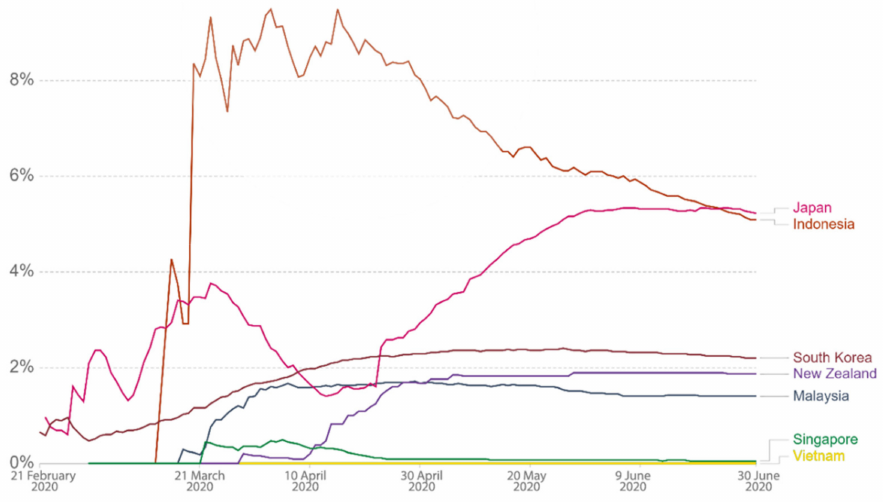
Figure 5. Mortality rates of each country. Source: Roser et al. [14]. Retrieved from